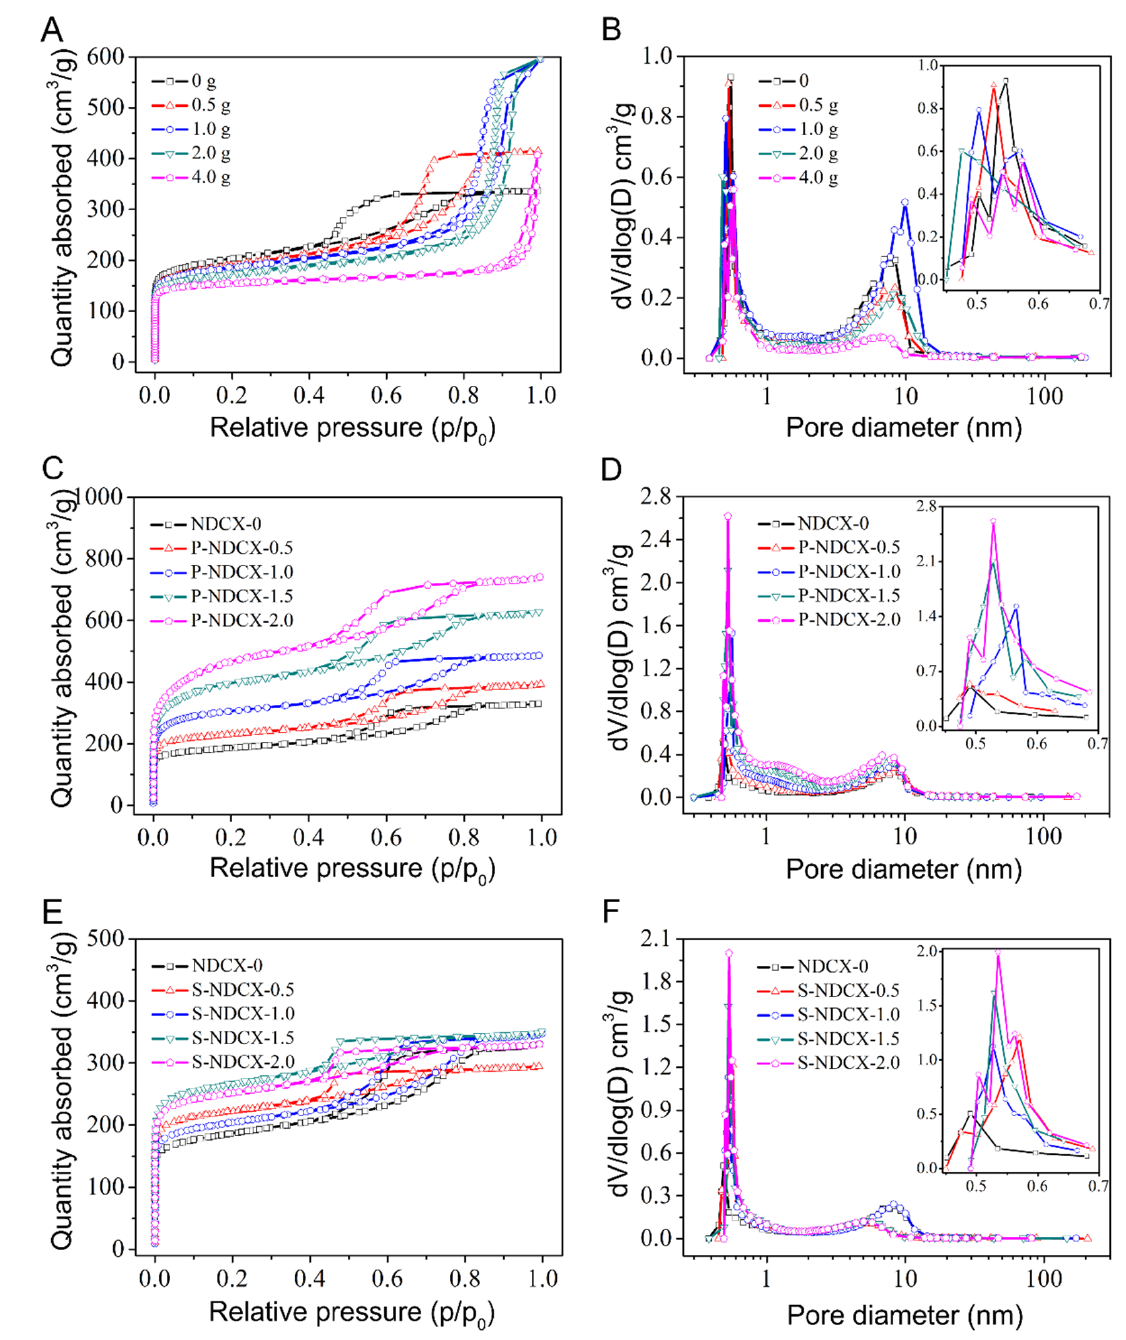
Figure 2. N 2 sorption isotherms ( A , C , E ) and pore distributions ( B , D , F ) of carbon xerogels with different amounts of dicyandiamide, P-NDCX-m, and S-NDCX-m. After the co-doping of P and S atoms on NDCX, the position and shape of the hysteresis were restored to that of the materials with low N doping, as shown in Figure 2C,E. This may be attributed to high temperature NDCX reprocessing, which removes excess N